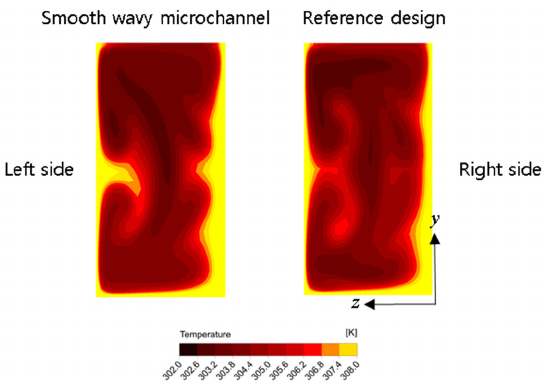
Figure 12. Temperature distributions at inflection point ( x /2 P = 6) in the y – z